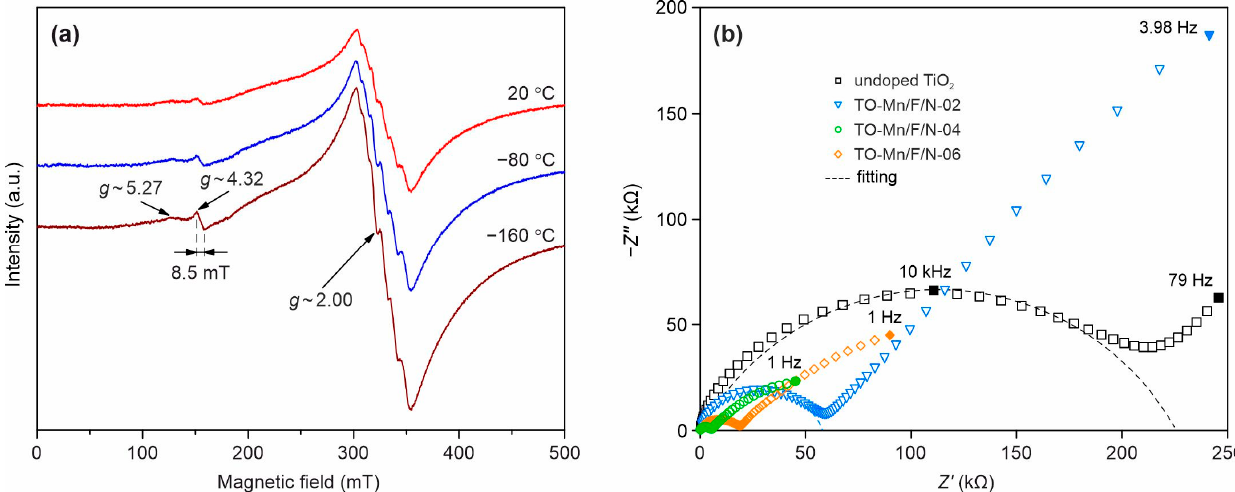
Figure 7. ( a ) X-band EPR spectra of (Mn, F, N) co-doped TiO 2 (B) at different temperatures and ( b ) Impedance spectra of undoped TiO 2 , TO-Mn/F/N-02, TO-Mn/F/N-04, and TO-Mn/F/N-06 samples with corresponding fitting curves.